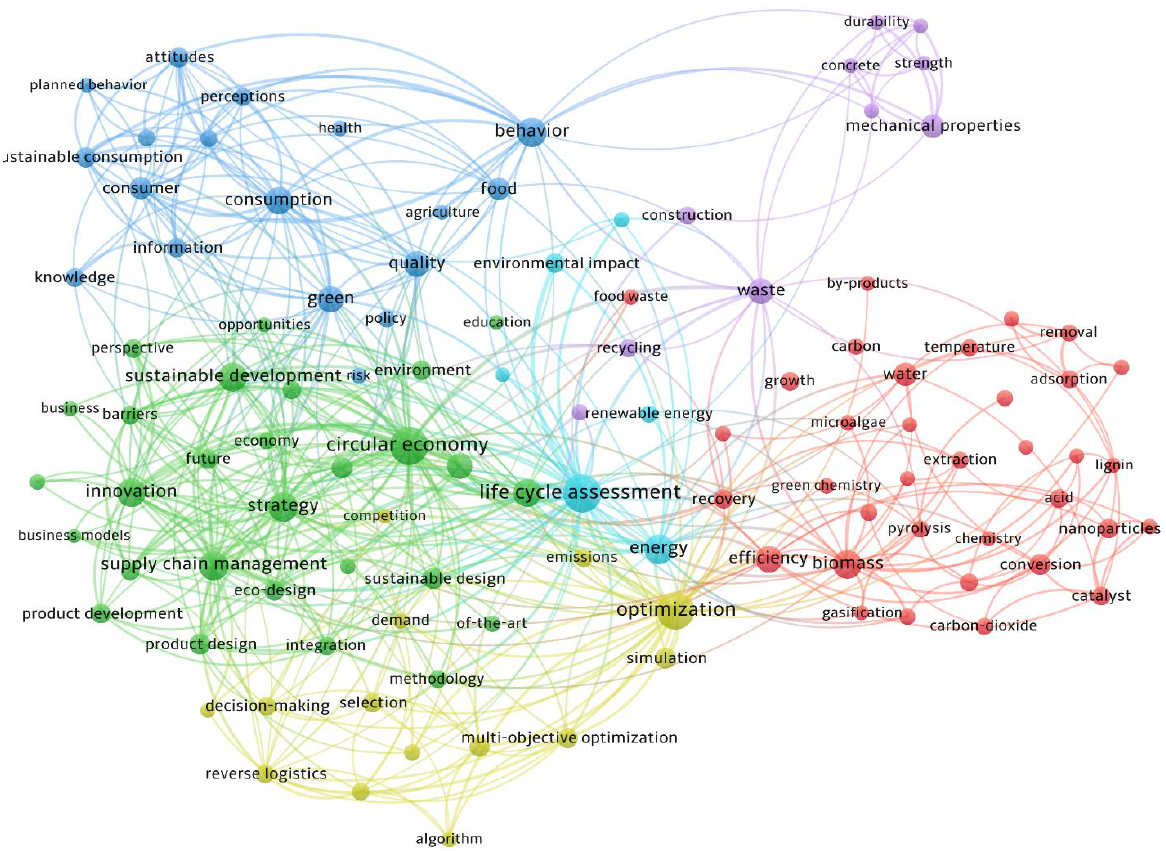
Figure 3. Network map with publications’ author keywords co-occurring 50 times or more.